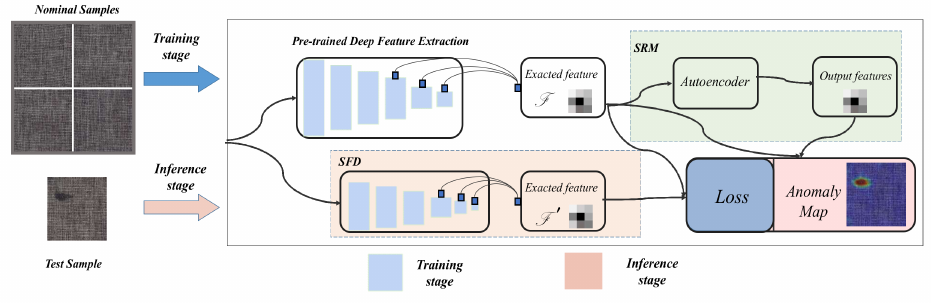
Figure 1. The pipeline of the SFC